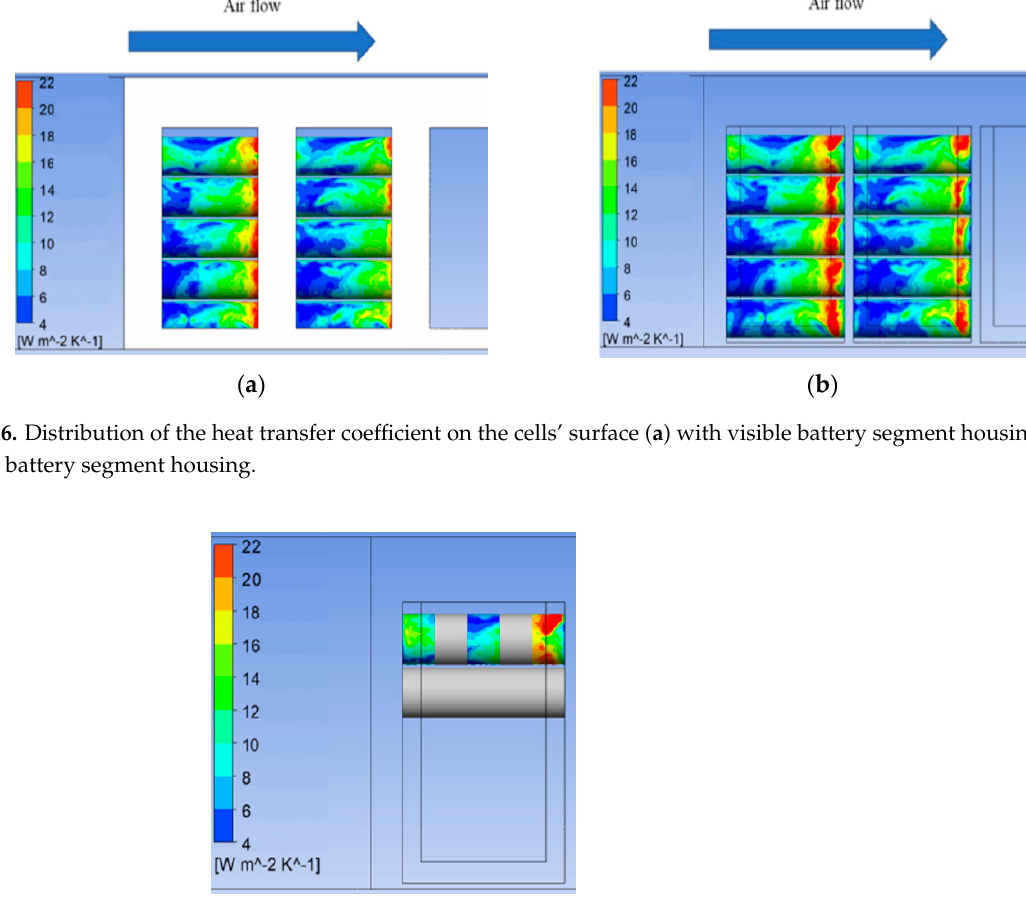
Figure 7. Heat transfer coefficient profiles of the divided sections of a battery cell.